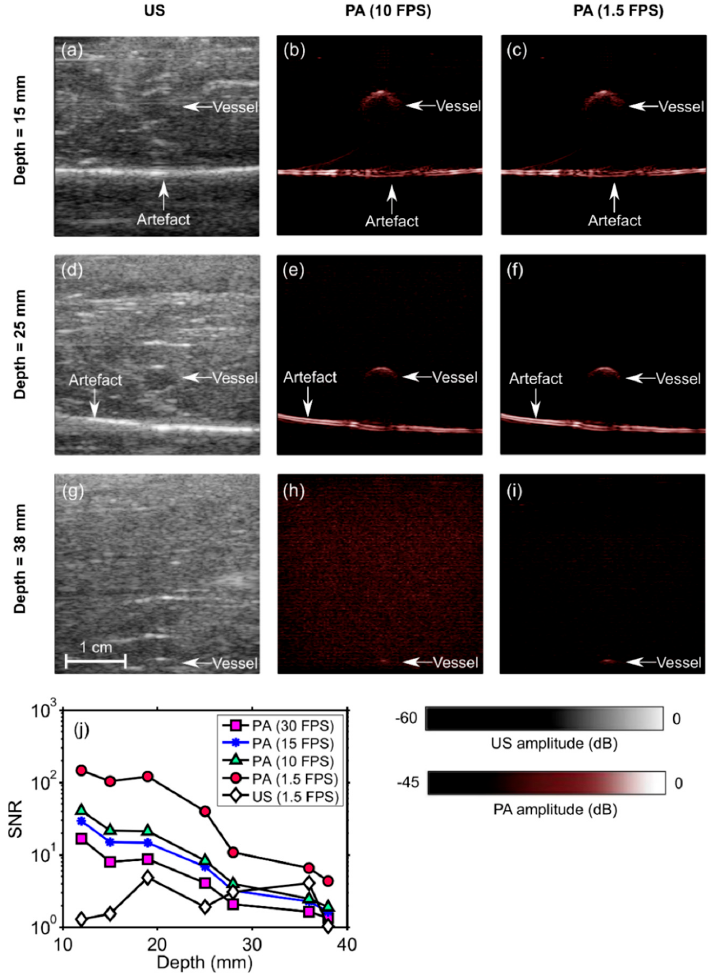
Figure 4. Photoacoustic (PA) and ultrasound (US) images of a phantom comprising a vessel positioned in chicken breast tissue at different depths ( a – i ). The signal-to-noise ratio (SNR) of the PA images decreased with the vessel depth and with the imaging frame rate ( j ). At 1.5 frames per second (FPS), the SNR of the US images was lower than that of the PA images for all depths. During the insertions, these images were reconstructed and displayed in real-time on a logarithmic scale. Here, they are presented without the uppermost 5 mm, which contained the ultrasound gel. FPS: frames per second. Each point in the SNR plots was calculated from one spatial region.